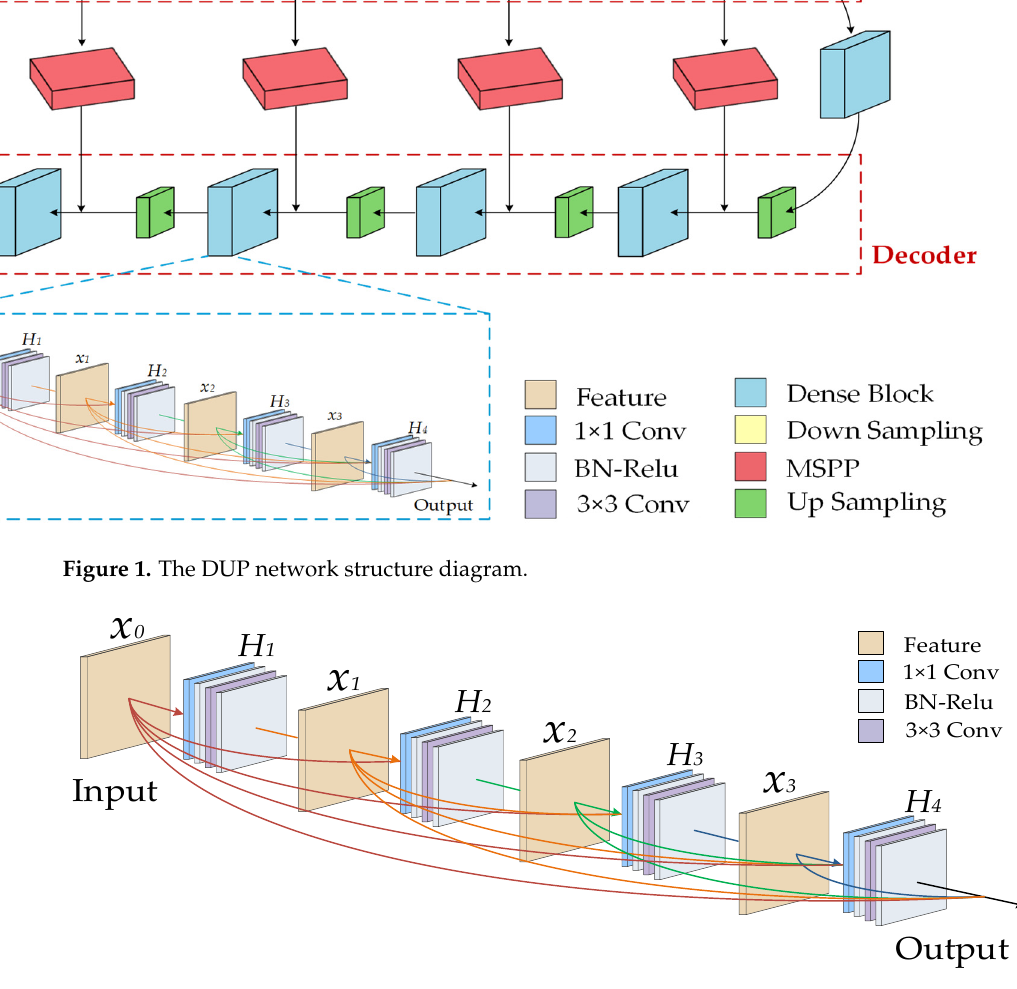
Figure 2. The dense block (DB) in DUPnet, l is 4, and the growth rate is 24. Each DB contains four 1 × 1 convolutions, four 3 × 3 convolutions, and four feature fusions, as shown in Figure 2. The number of input feature maps can be reduced by introducing a 1 × 1 convolution before each 3 × 3 convolution. The BN and ReLU layers are added after each convolution layer of the DB [39].